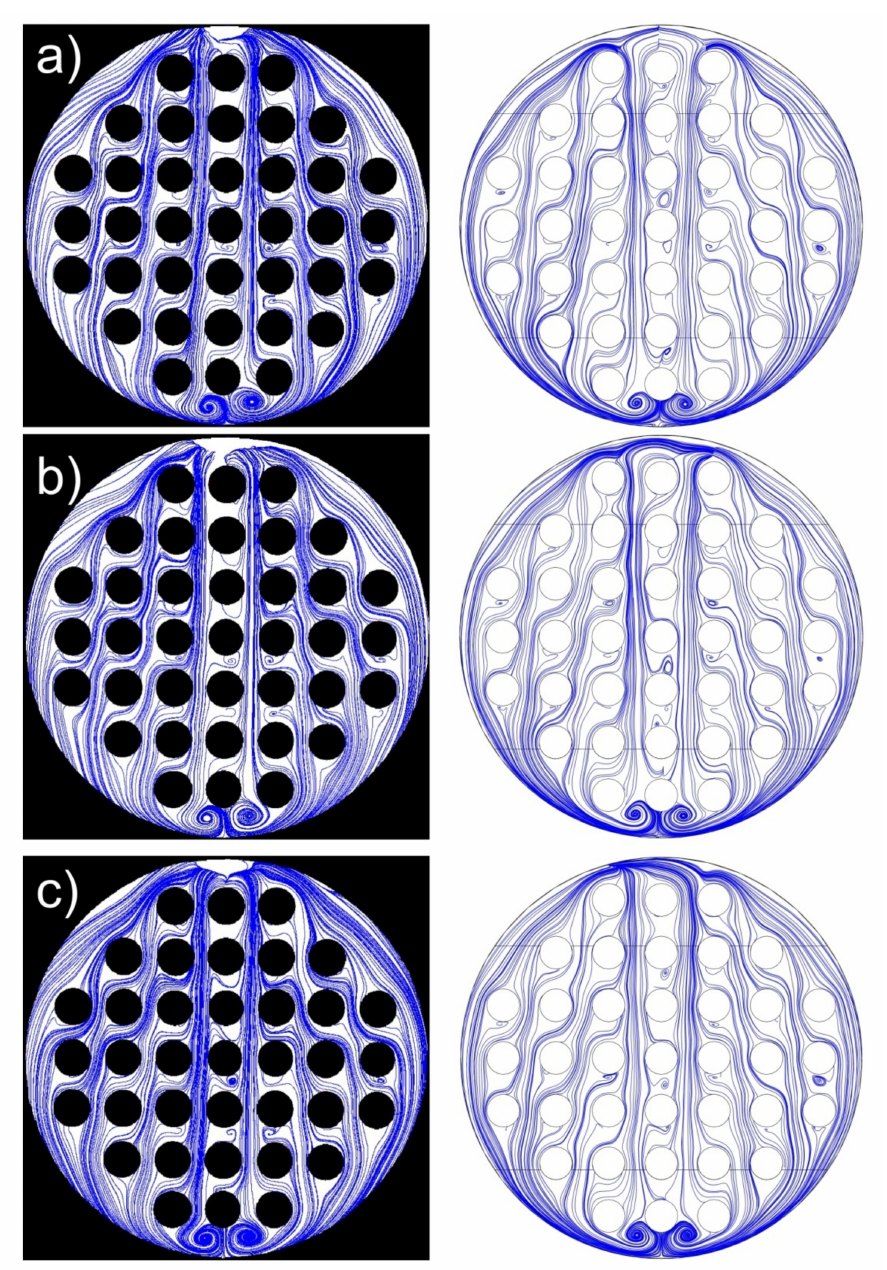
Figure 18. Comparison of streamlines PIV (left row) and CFD (right row) for various liquid flow rate: ( a ) Q = 5 m 3 / h, ( b ) Q = 7.5 m 3 / h, and ( c ) Q = 10 m 3 /